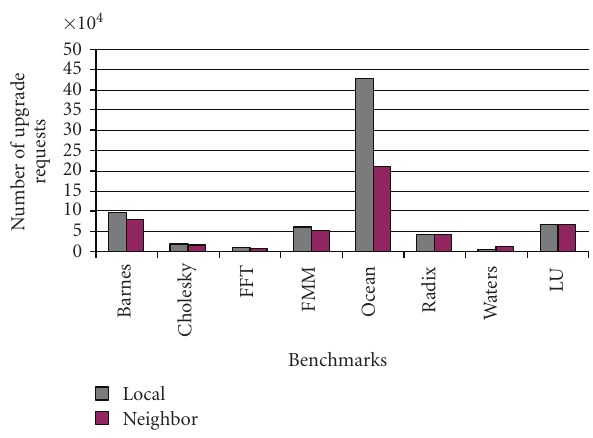
Figure 19: Profiling results for upgrade requests.